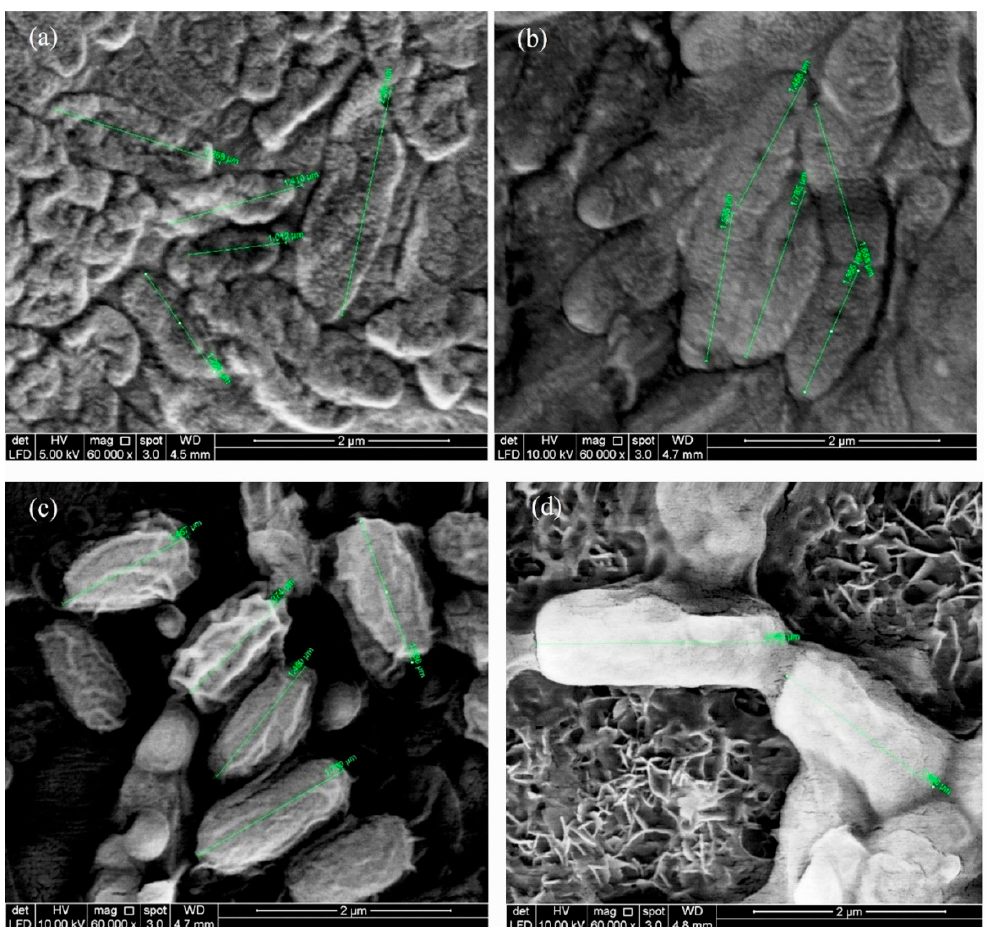
Figure 1. ( a ) SEM image of bacterial strain B1 at 60,000 × magnification; ( b ) SEM image of bacterial strain B2 at 60,000 × magnification; ( c ) SEM image of bacterial strain B3 at 60,000 × magnification; ( d ) SEM image of bacterial strain B4 at 60,000 × magnification.